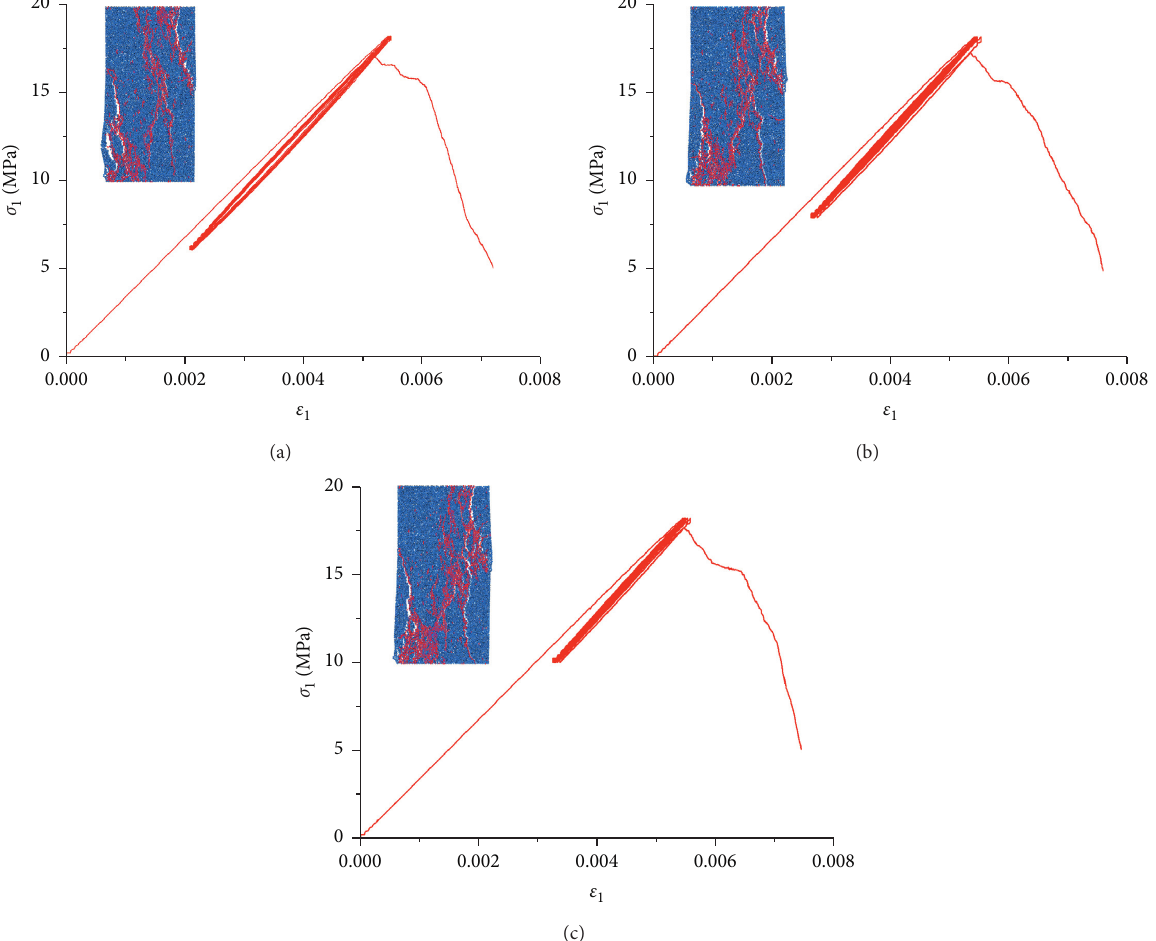
Figure 12: The axial stress- strain curves under different valley stresses: (a) 6 ∼ 18.18MPa, (b) 8 ∼ 18.18MPa, and (c) 10 ∼ 18.18